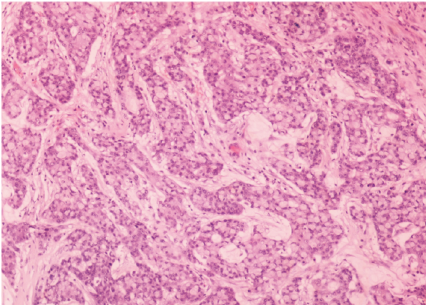
Figure 1: Hematoxylin and eosin staining (original magni fi cation × 400): poorly di ff erentiated with signet ring colon adenocarcinoma with extracellular